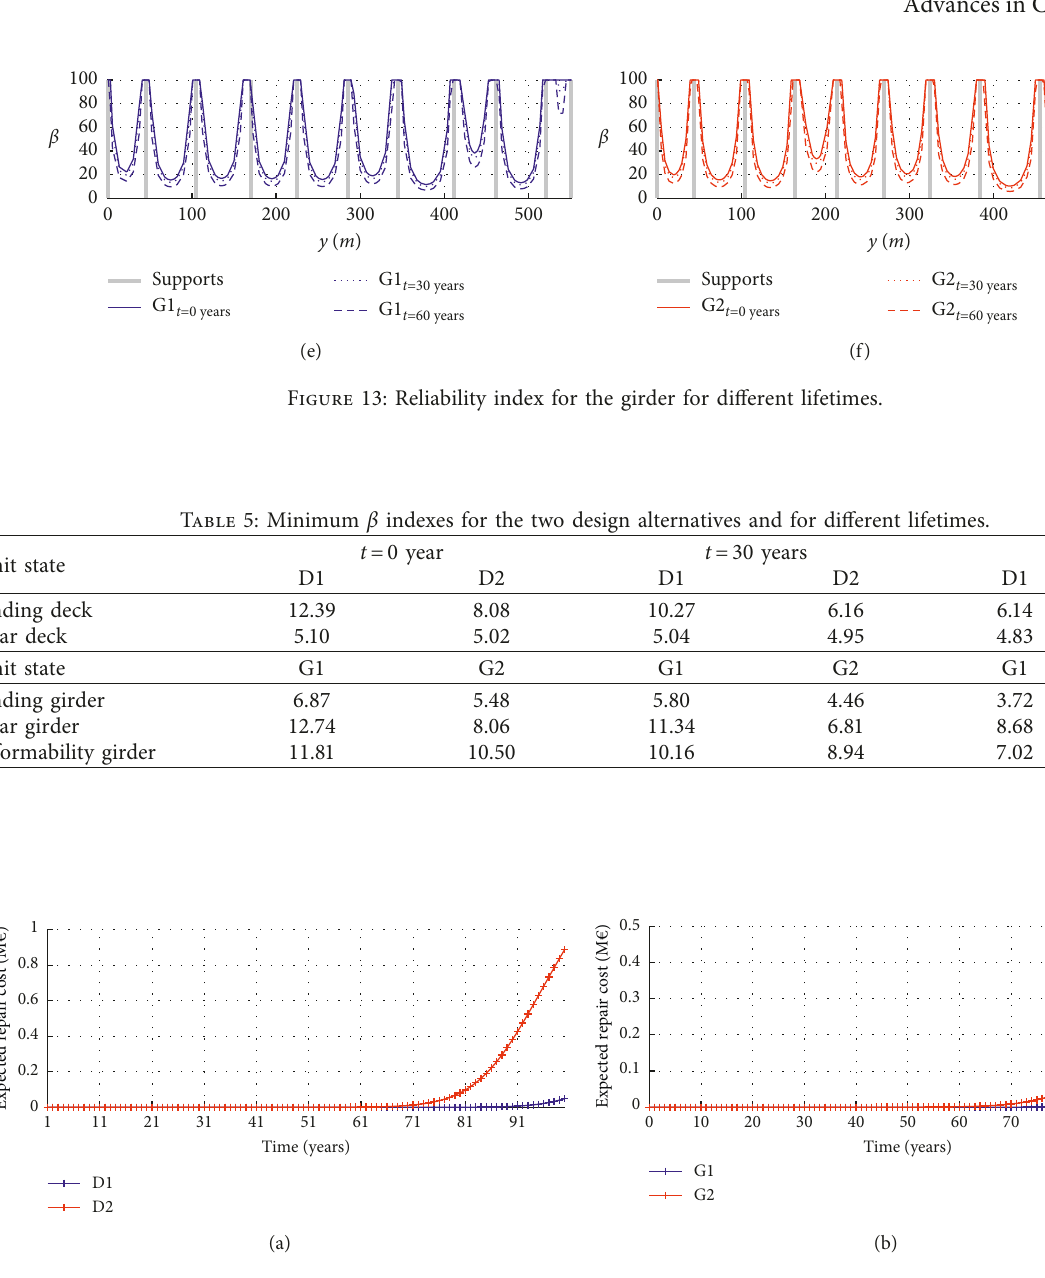
Figure 14: Expected repair costs over a lifetime for the deck (a) and the girder (b), for the two design